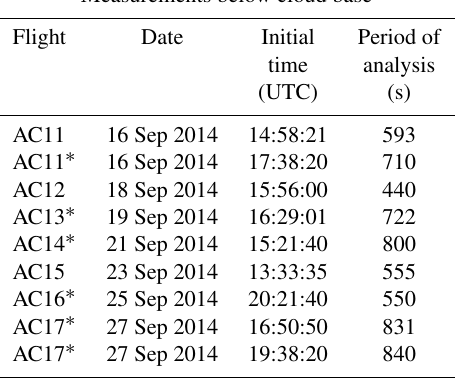
Table 3. List of case studies for measurements below cloud base. The duration of measurements is given in seconds, starting at the initial time indicated. An asterisk indicates flights during which the two probes provided at least 20s of measurements at cloud base. The data can be from different cloud passes in the same measure- ment region below cloud